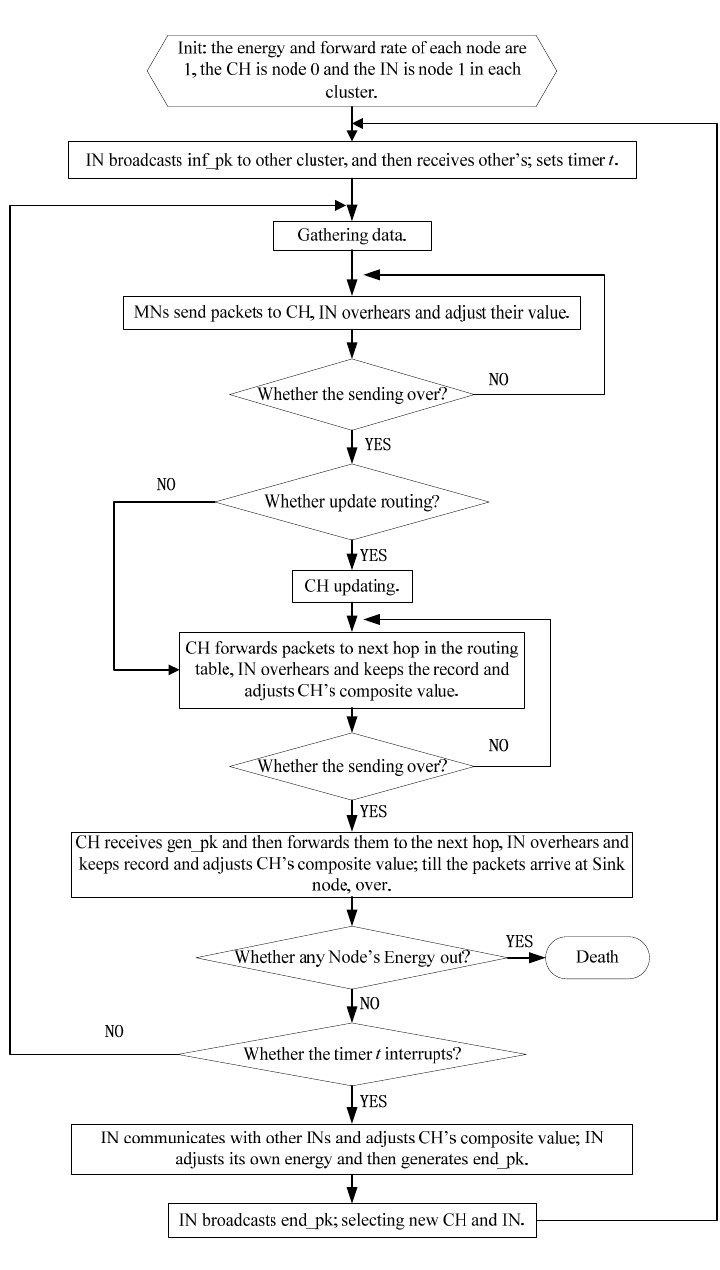
Figure 5. Workflow of local network.